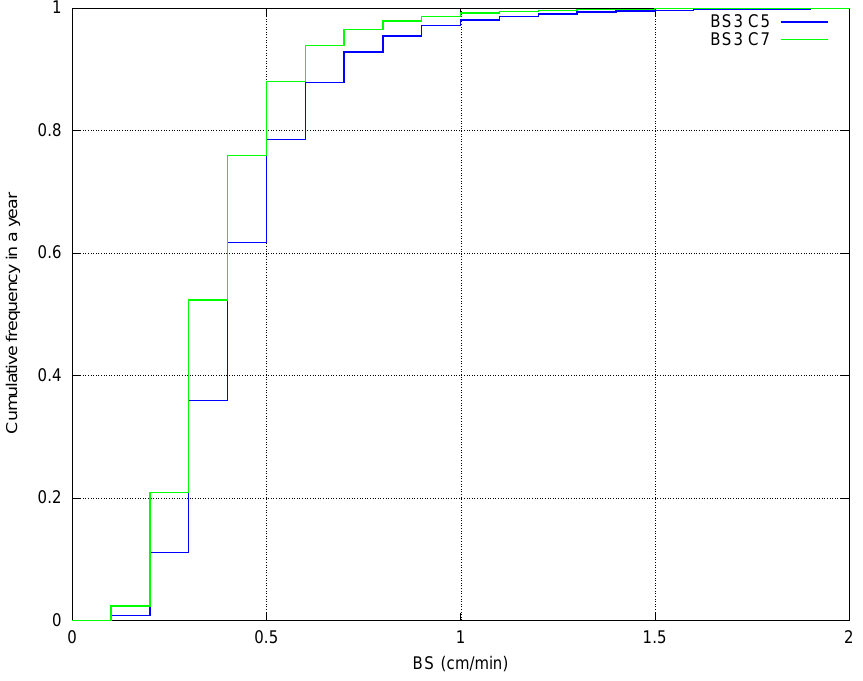
Fig. 9b. Cumulative distribution of BS3 for the configurations A3C5 and